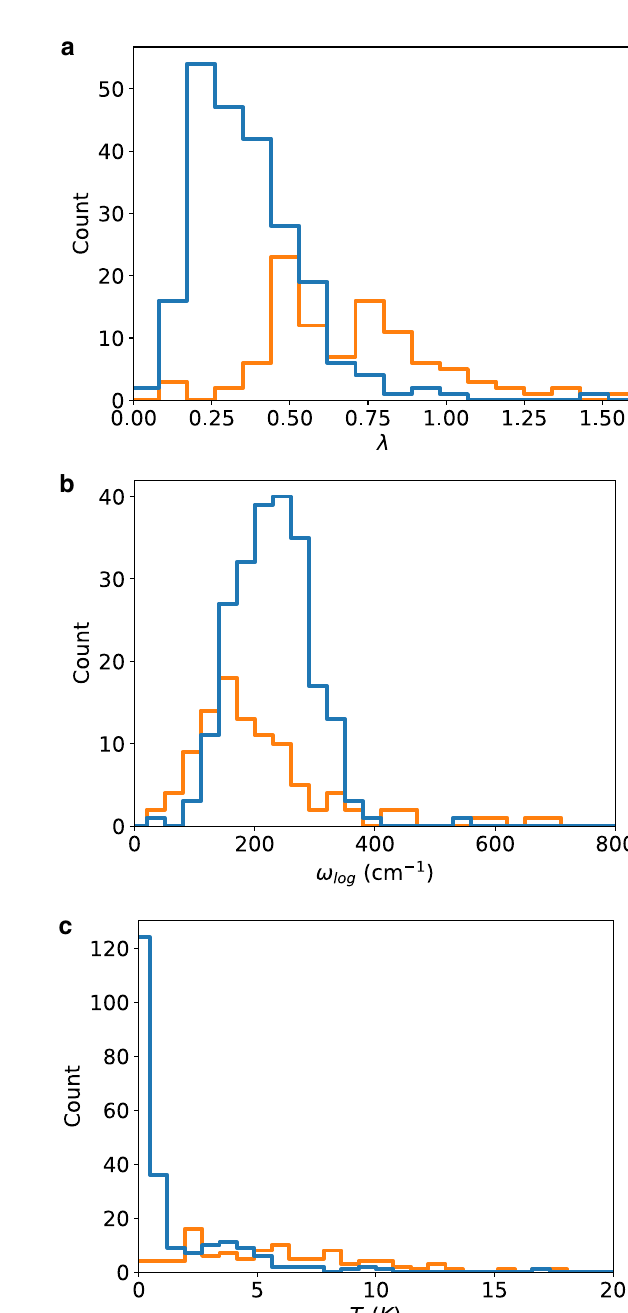
Fig. 1 Histograms of the electron-phonon coupling constant, the averaged phonon frequency and the superconducting transition temperature. ( a ) A histogram of the calculated values of the electron- phonon coupling constant λ ; ( b ) a histogram of the averaged phonon frequency ω log ; and ( c ) a histogram of the superconducting transition temperature T c . The blue curves are for systems with distances to the hull below 50 meV/atom and the orange curves for systems between 50 and 400 meV/atom predicted to have high values of the transition